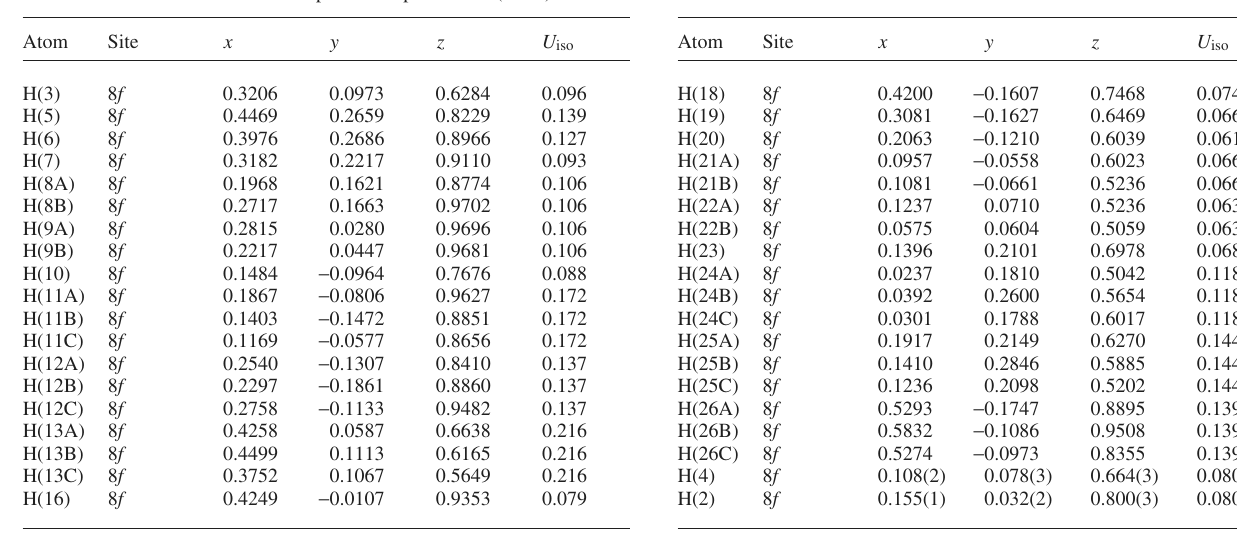
Table 2. Atomic coordinates and displacement parameters (in Å 2 )